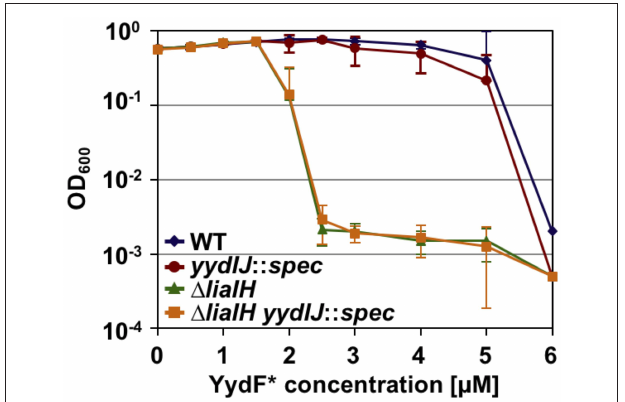
FIGURE 4 | Minimum inhibitory concentration (MIC) assay of B. subtilis treated with YydF*. Optical density endpoint measurements after 24h are plotted over the indicated YydF* concentrations. Next to the wild type (blue), a yydIJ mutant (red), a liaIH knockout strain (green), and the corresponding double mutant (orange) are